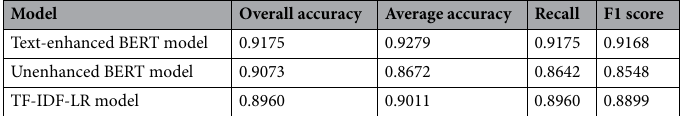
Table 5. Model comparison